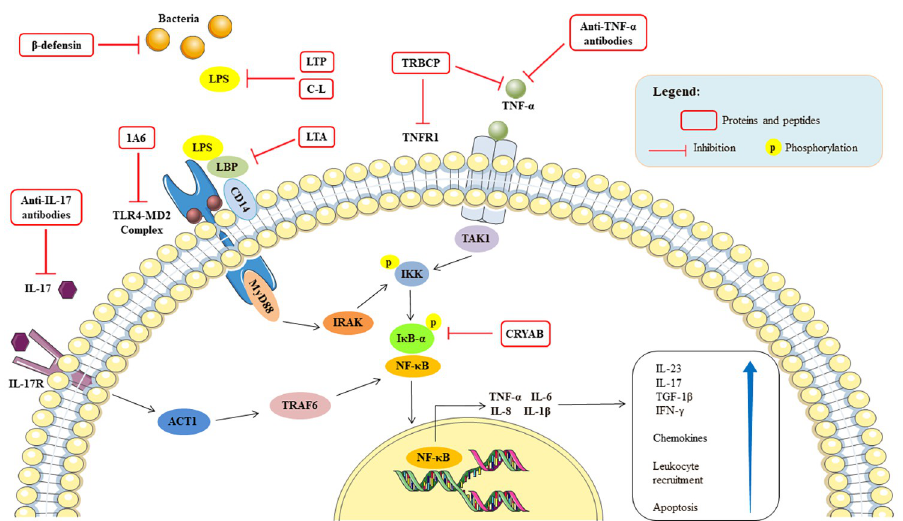
Fig 3. Schematic illustration of a hypothetical immune cell, presenting the main mechanisms discussed about the action of anti-inflammatory proteins and peptides with anti-TNF-alpha activity that act on the intestinal barrier. The figure was built using the Servier Medical Art images (smart.servier.com). IFN: interferon, IL: interleukin; LBP: LPS-binding protein; LPS: lipopolysaccharide; TGF: transforming growth factor; TLR4: tool like receptor 4; TNF- α : tumor necrosis factor alpha; TNFR: tumor necrosis factor alpha